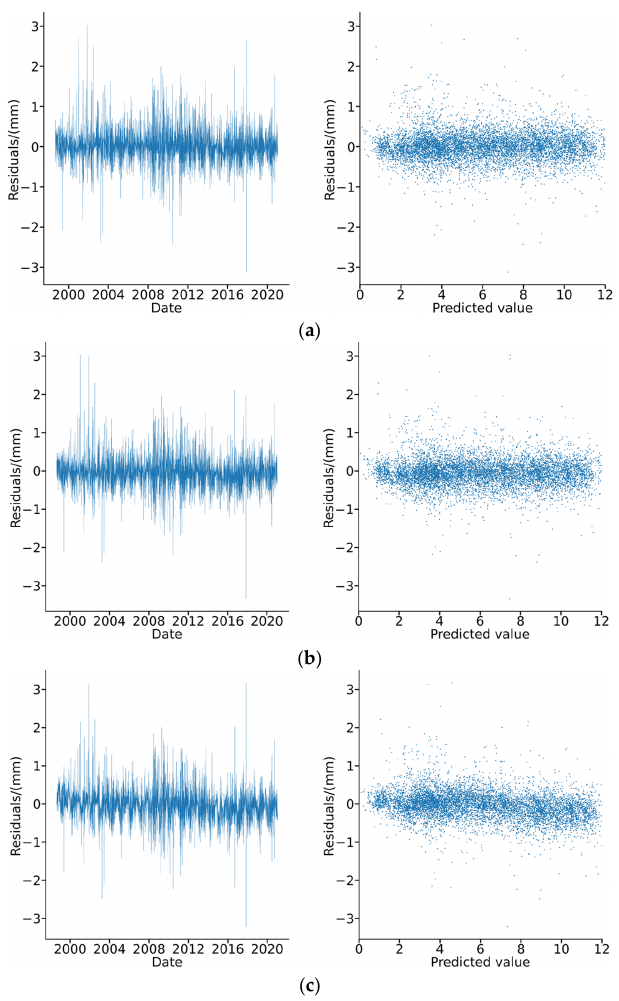
Figure 13. Residuals distribution plot of different models: ( a ) attention mechanism is coupled before LSTM; ( b ) attention mechanism is coupled after LSTM; and ( c ) LSTM.